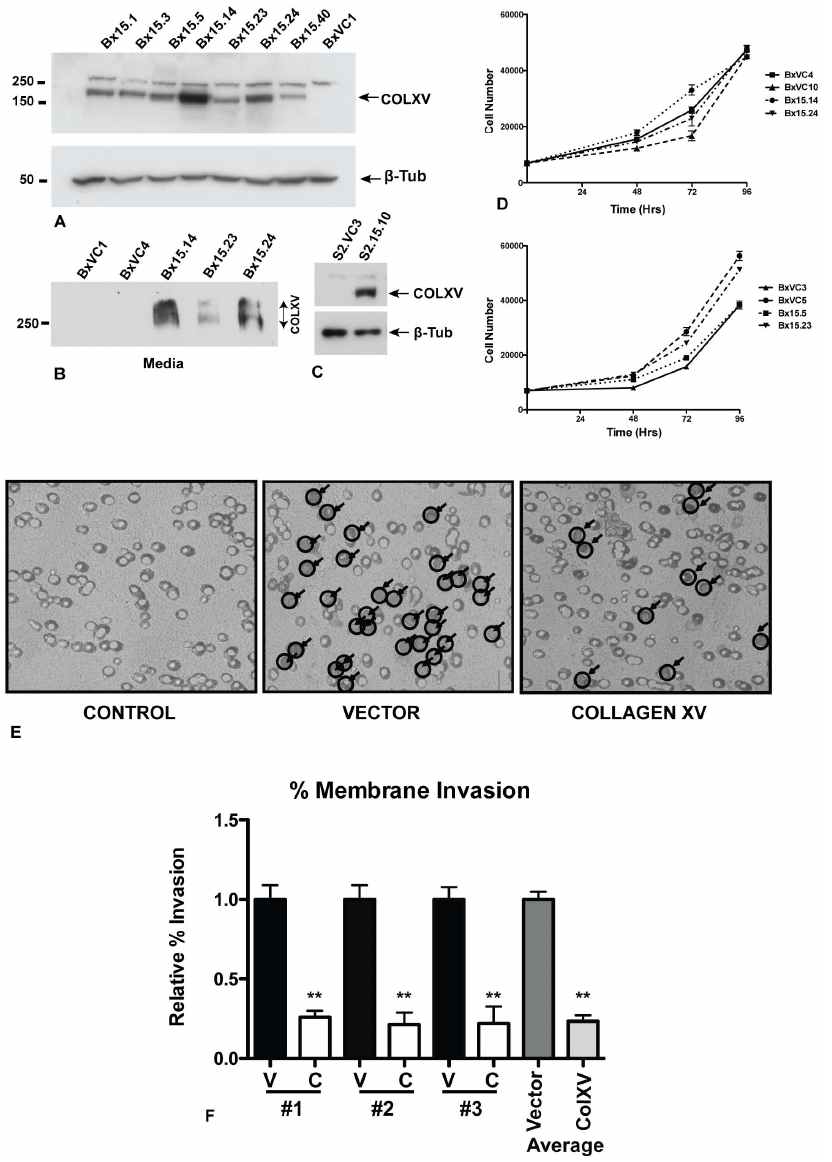
Figure 1. Collagen XV inhibits invasion of BxPC cells though a collagen I-coated membrane. A) Stable expression of collagen XV in BxPC- 3 and S2-013 pancreatic adenocarcinoma cells. Western blot probed with anti-COLXV antibody or anti-ß-tubulin loading control. Clones Bx15.1-15.40 express variable levels of COLXV. Also shown is one vector control clone (BxVC1). Note: the anti-COLXV antibody cross-reacts with an irrelevant higher MW protein that is seen in many cell types, irrespective of COLXV expression. B) The COLXV is secreted from BxPC-3 cells into the cell culture media. C) COLXV expression in a representative stable clone of S2-013 cells (S2.15.10), also shown is a vector control (S2.VC3). D) Growth rates of 4 BxPC-3 vector control clones and 4 COLXV-expressing clones are independent of COLXV expression. E, F) Invasion assay: E) vector (BxVC1, BxVC3) or COLXV (Bx15.14 and Bx15.23) cells plated on a membrane coated with COLI. After 72 hr cells invading through the membrane were stained, visualized and counted at 40X magnification. Random fields were selected from three independent experiments representing n=16 vector plates (BxVC1, BxVC3) and n=15 COLXV plates (Bx15.14 and Bx15.23). F) The average of each independent experiment is shown # 1, # 2, # 3, (Left, V=vector control; C=COLXV) and the cumulative average of all triplicates